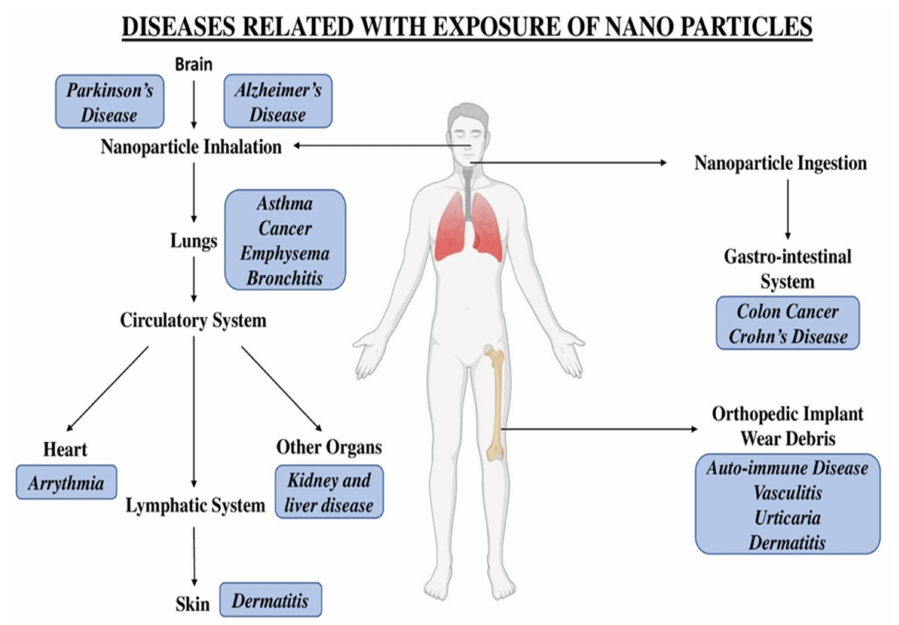
Figure 4. Diseases associated with nanoparticle exposure